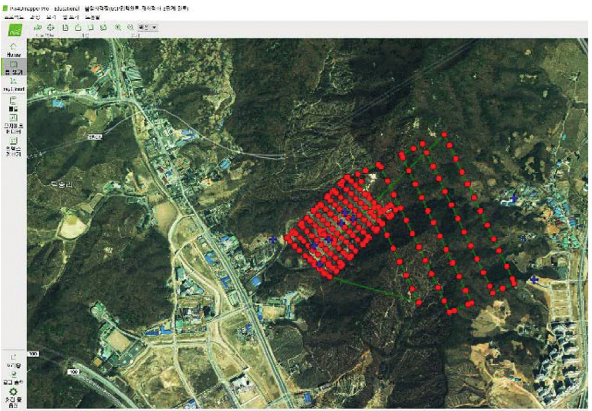
Figure 5: Uploading photos and coordinate system settings.